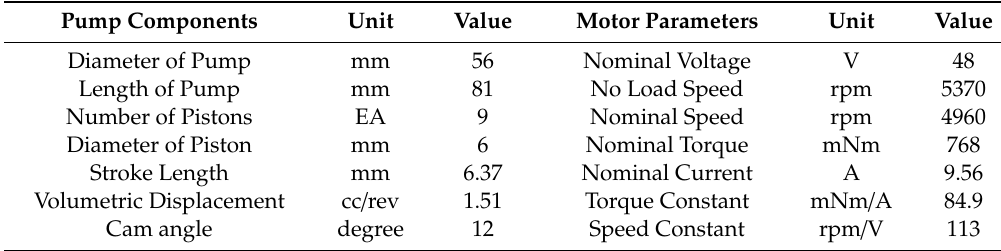
Table 2. The specifications of the desired pump and the